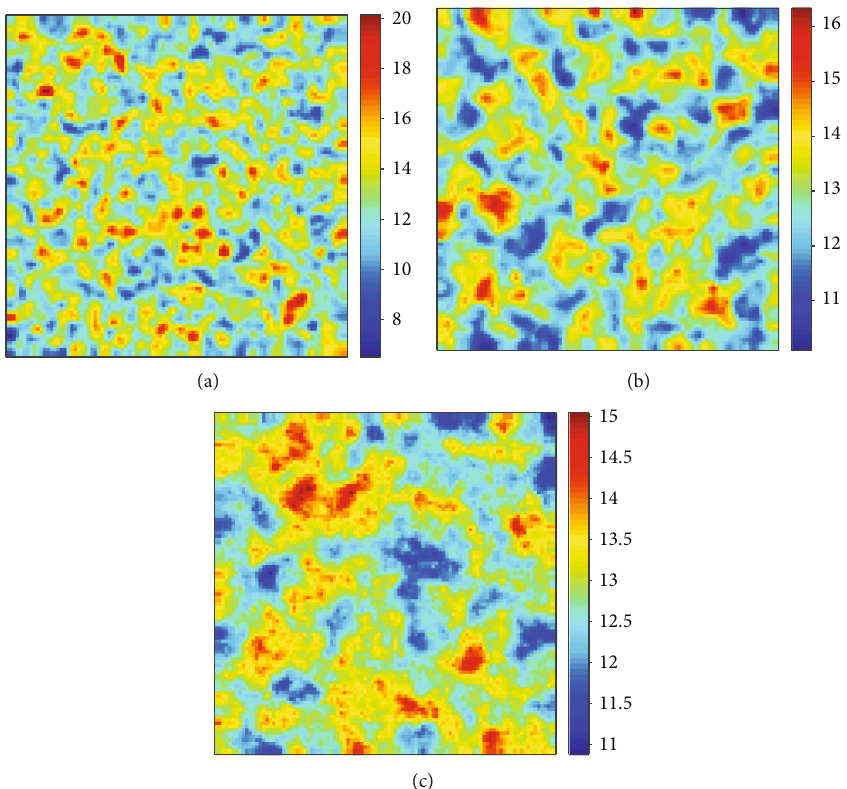
= 1 ), b ( u = 0 : 5 ), c ( u = 0 : 1 k k k